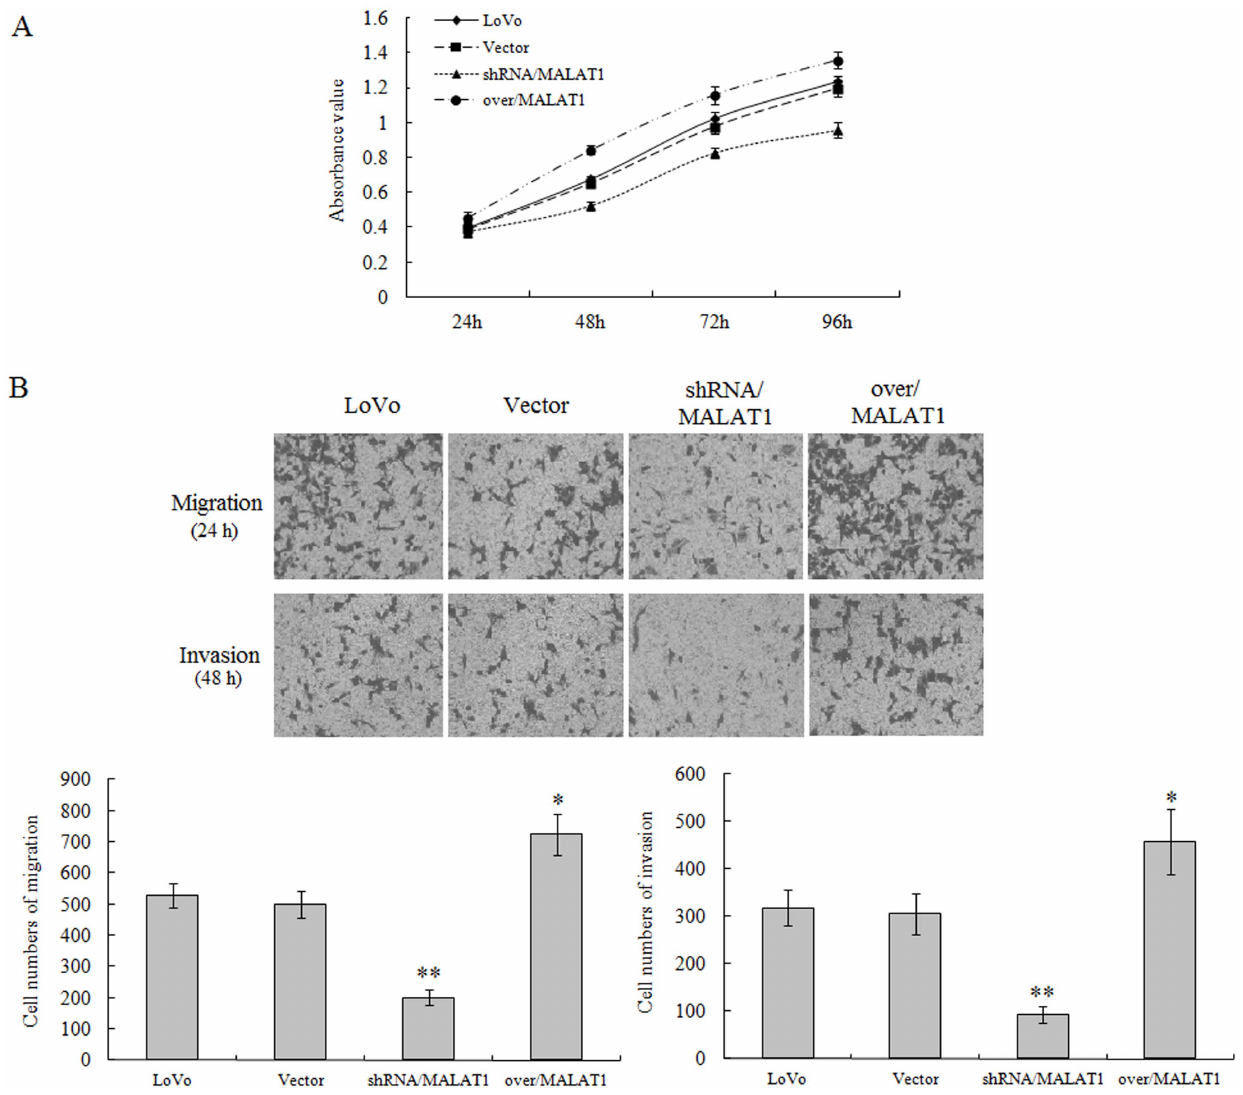
Figure 4. MALAT1 promotes the proliferation, invasion and migration of LoVo cells. (A): In vitro growth of LoVo cells expressing MALAT1- shRNA, MALAT1-overexpression, empty vector vs. parental cells. (B): Assessment and quantification of cell migration and invasion of indicated LoVo cells in A. Values represent the number of migratory/invasive cells per 5 high power fields. * p , 0.05 or ** p , 0.01, compared with control LoVo group.